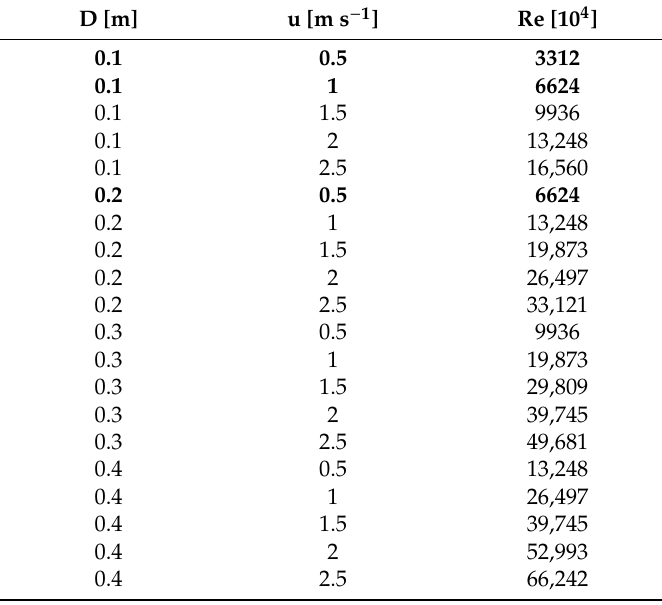
Table 3. Reynolds numbers evaluated at 20 ◦ C for each diameter and inlet velocity couple. In bold the couples for which the motion in not fully